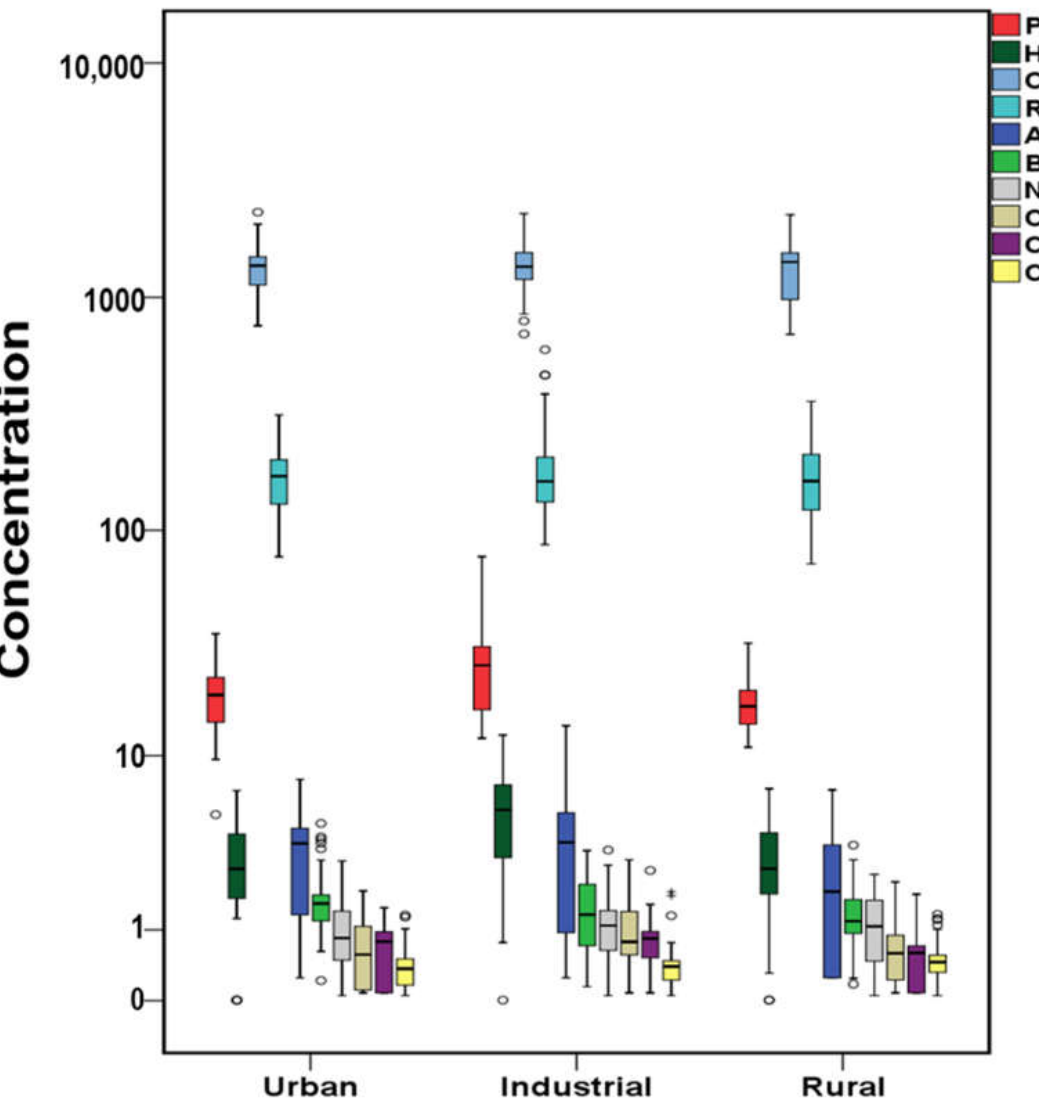
Figure 11. Trace elements variation according to the area of residence of cases in μg L −1 ( + outliers and o values above 3rd quartile and * p -value <0.05) in logarithmic scale.